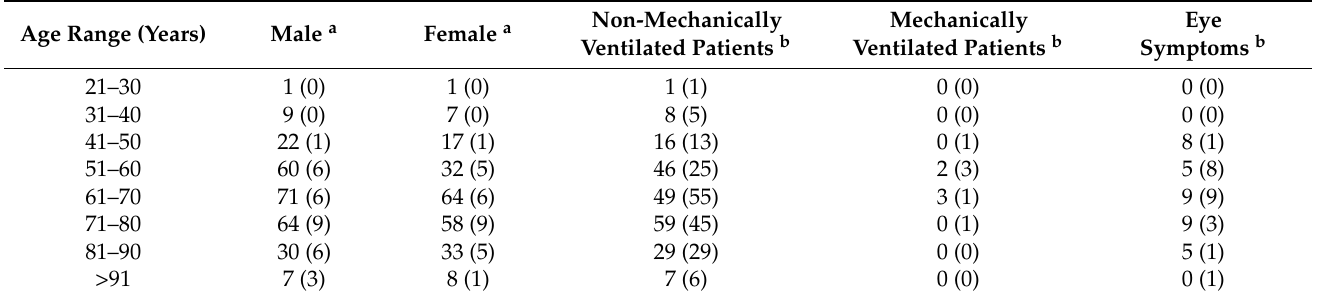
Table 2. The overview of all patients with COVID-19-positive PCR test and the patients with a positive result from the conjunctival sac divided by age and gender.